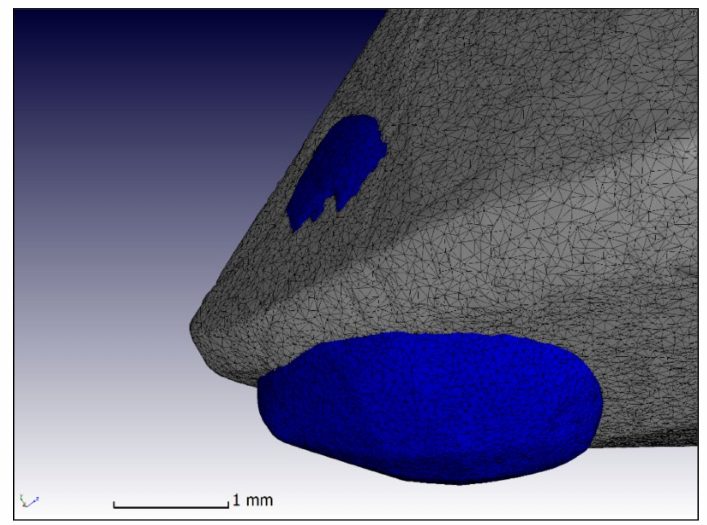
Figure 7. The best-fit registration of the diffused sapphire A exterior surface mesh (blue) with that of the EGL ruby exterior surface mesh (grey) illustrates the dissimilarities between the two